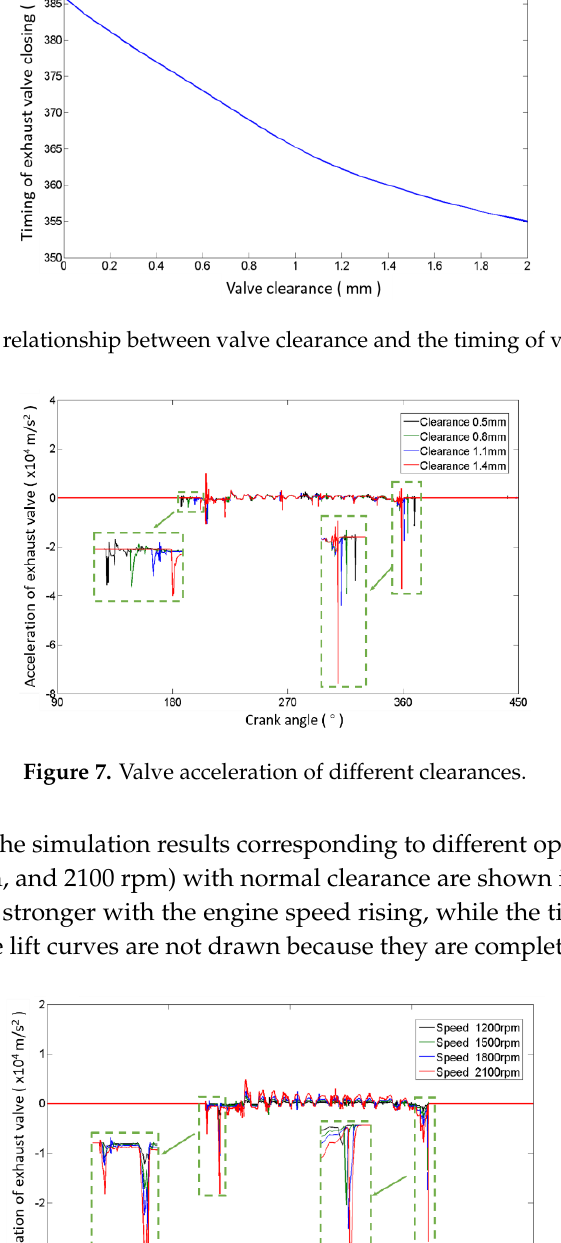
Figure 8. Valve acceleration of different speeds.